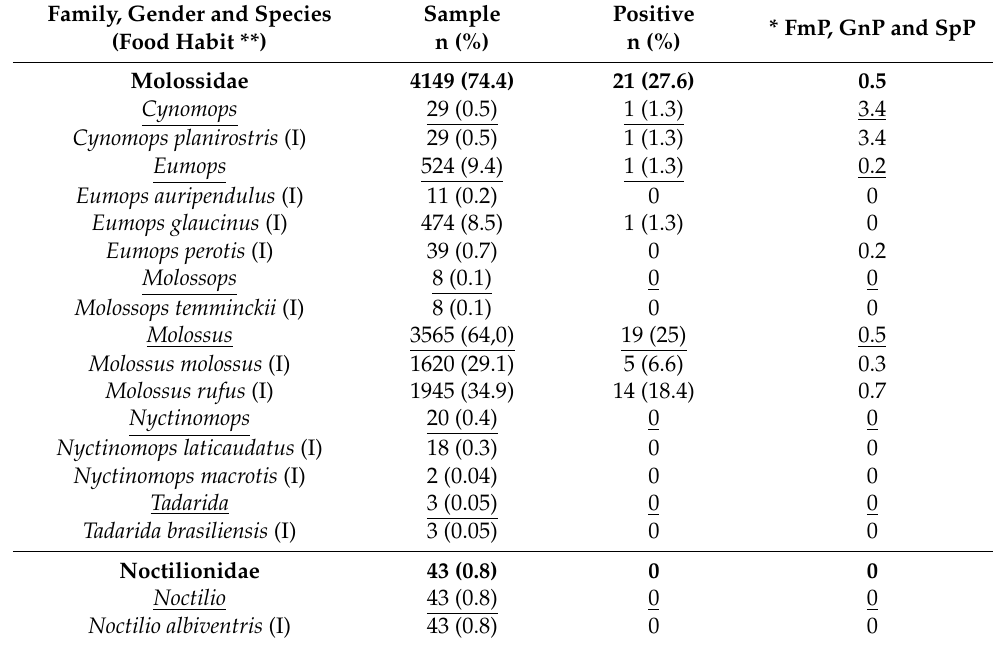
Table 2. Number and percentage of bats sent to the Unesp Araçatuba Rabies Laboratory from 1998 to 2017 according to taxonomic classification, results and prevalence